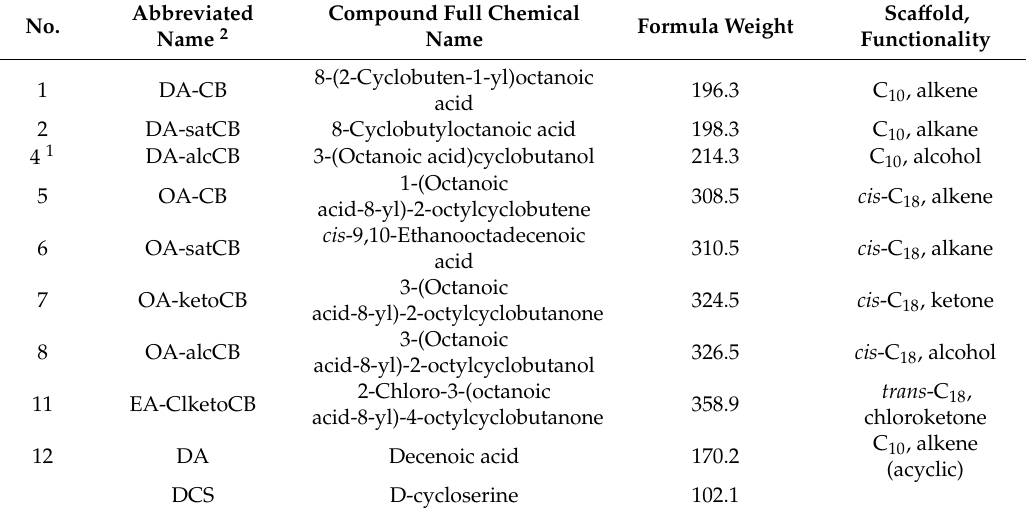
Table 1. Fatty acid derivatives used in this study.